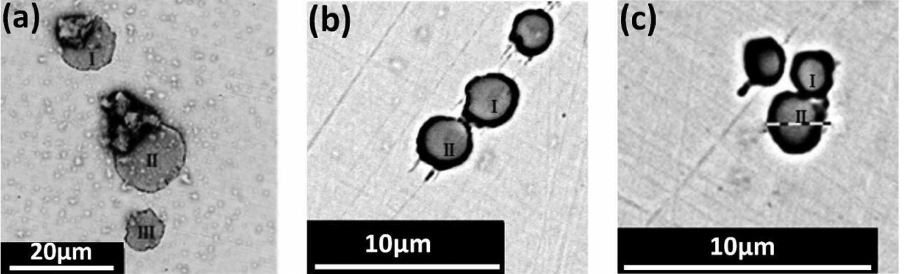
Figure 7: SEM images for differ- ent sizes of MnS